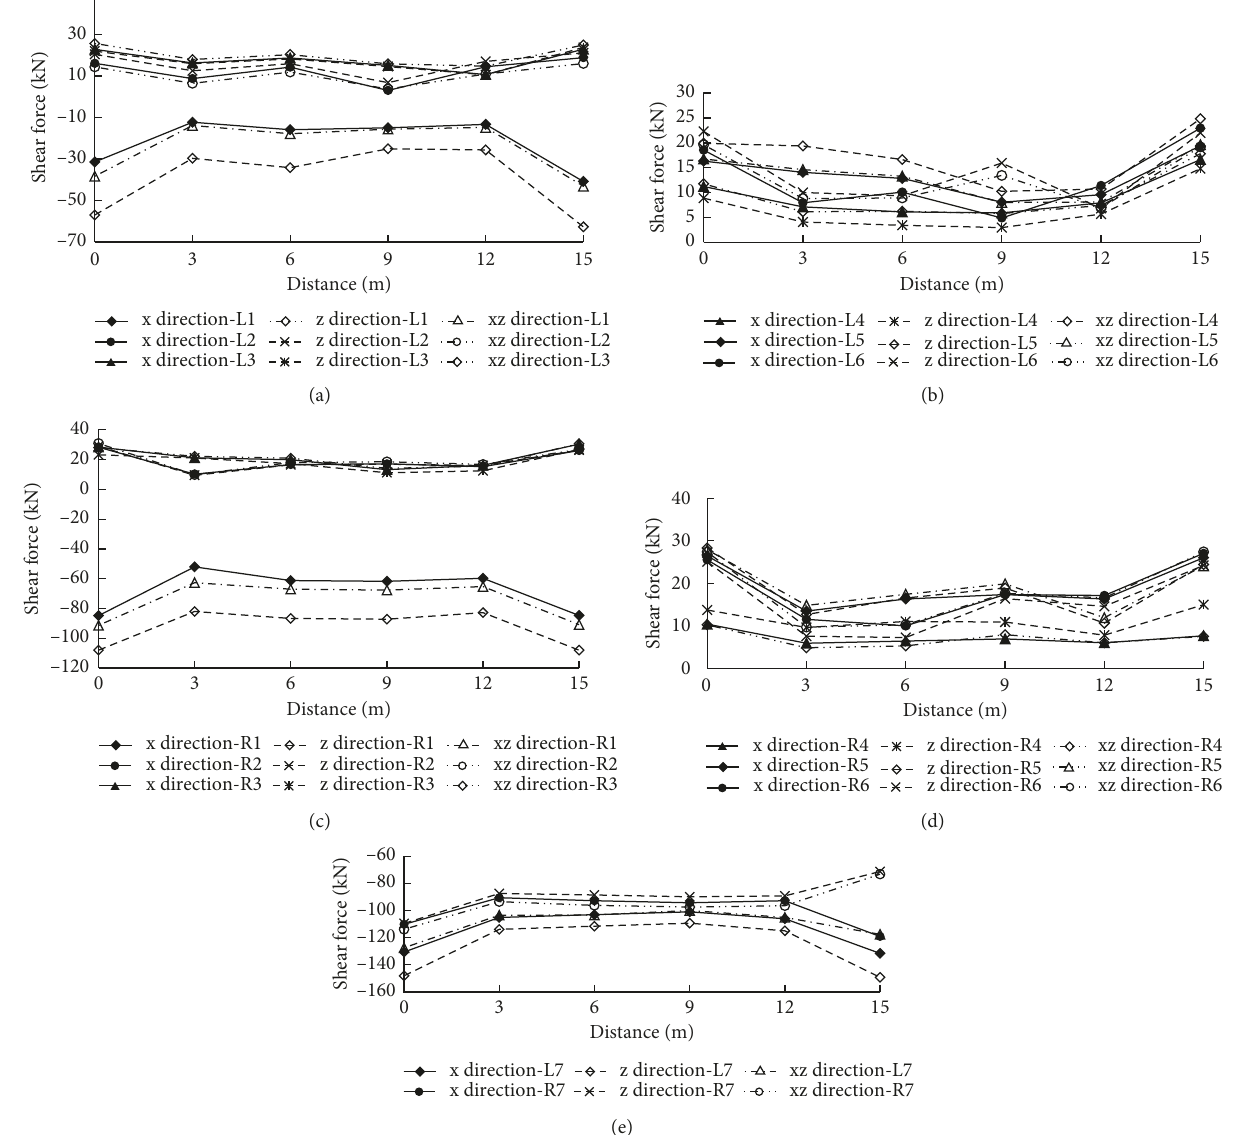
Figure 9: The shear force of tunnel lining along longitudinal